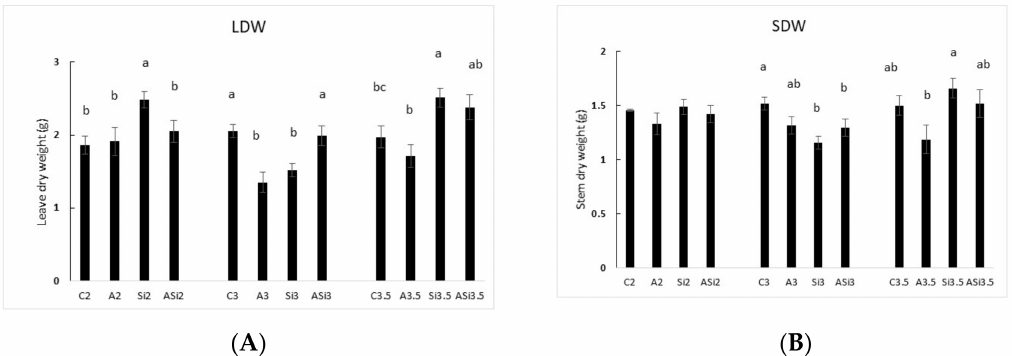
Figure 5. LDW ( A ) and SDW ( B ) (g) at the end of the trial for the C2 (foliar application with water and fertigation EC 2.0 dS m − 1 ), A2 (foliar application with Arthrospira platensis and fertigation EC 2.0 dS m − 1 ), Si2 (foliar application with Si and fertigation EC 2.0 dS m − 1 ), ASi2 (foliar application with Arthrospira platensis and Si, and fertigation EC 2.0 dS m − 1 ), C3.0 (foliar application with water and fertigation EC 3.0 dS m − 1 ), A3.0 (foliar application with Arthrospira platensis and fertigation EC 3.0 dS m − 1 ), Si3 (foliar application with Si and fertigation EC 3.0 dS m − 1 ), ASi3 (foliar application with Si and Arthrospira platensis, and fertigation EC 3.0 dS m − 1 ) treatments; C3.5 (foliar application with water and fertigation EC 3.5 dS m − 1 ), A3.5 (foliar application with Arthrospira platensis and fertigation EC 3.5 dS m − 1 ), Si3.5 (foliar application with Si and fertigation EC 3.5 dS m − 1 ), and ASi3.5 (foliar application with Si and Arthrospira platensis, and fertigation EC 3.5 dS m − 1 ) treatments. Di ff erent letters indicate significant di ff erences between treatments at the p < 0.05 level using the LSD test. Values are the means of 12 plants. Error bars show standard